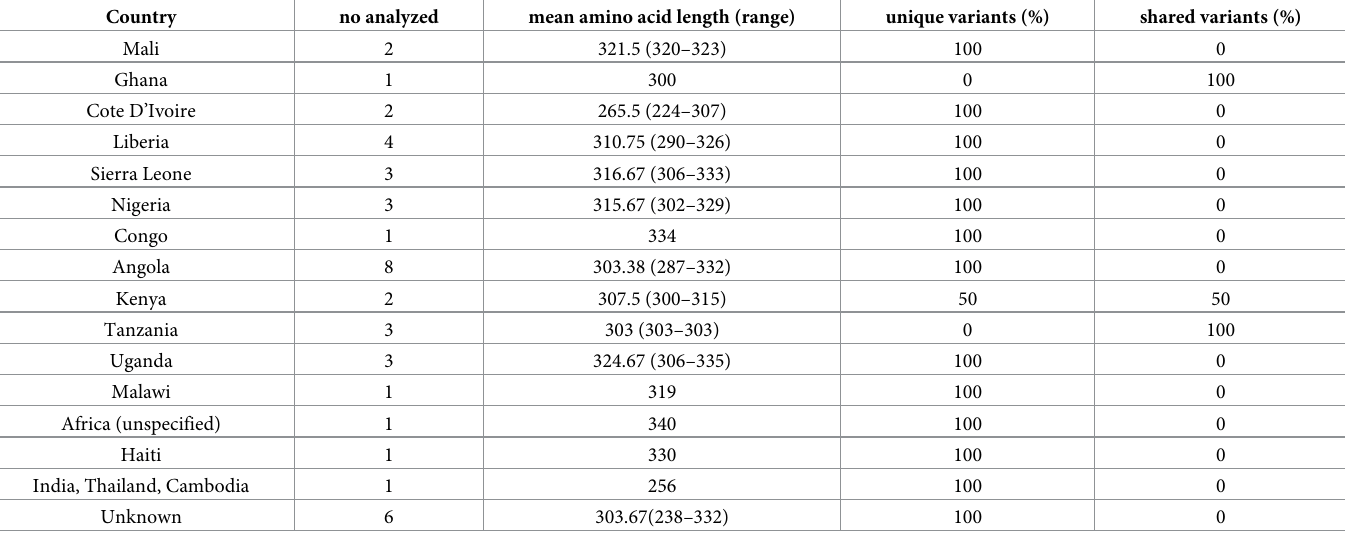
Table 7. Number and length of amino acids found in samples grouped by country.